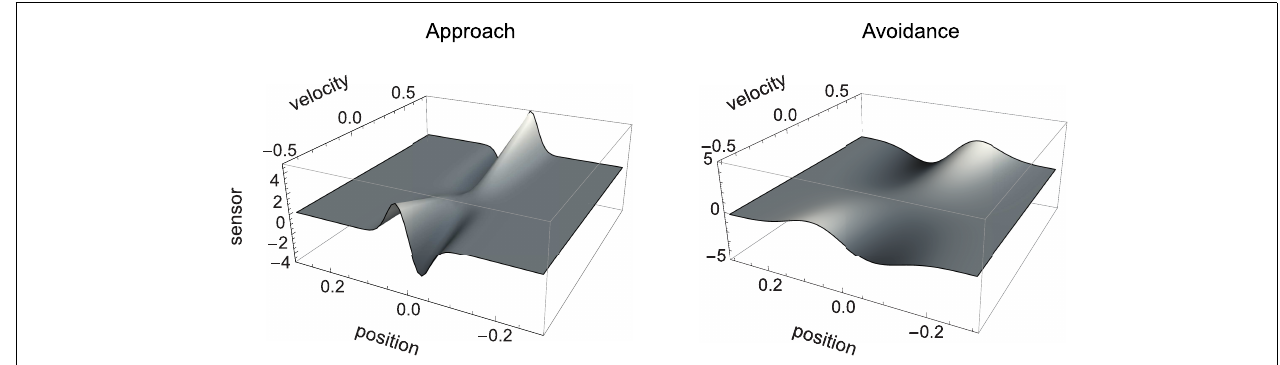
FIGURE 3 | SM environment for approach and avoidance conditions: sensory change that results from issuing a motor command that determines agent velocity at a given position . Slices of this surface along the position dimension correspond to derivatives of the original Gaussian shape (which is not surprising as the sensor outputs the time-derivative of measures distance).The amplitude of this derivative depends on the agent’s